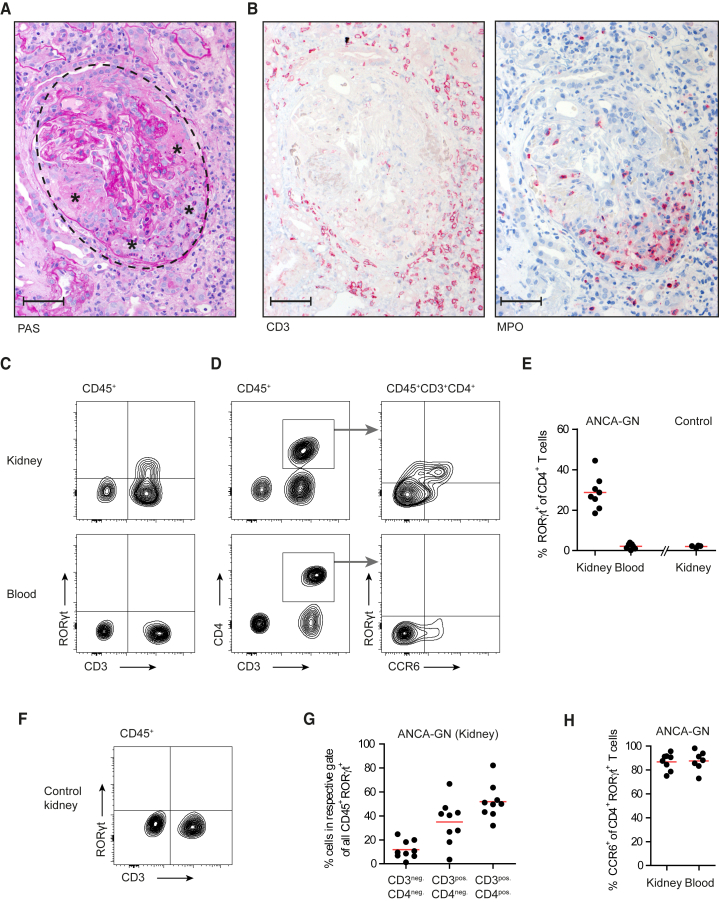
Identification and Characterization of Th17 Cells in the Kidneys of Patients with ANCA-Associated cGN(A) PAS staining of a renal biopsy from a patient with ANCA-GN (glomerulus: dashed line; crescent: asterisked).(B) Consecutive tissue sections were stained for CD3 (T cells) and MPO (neutrophils).(C) Leukocytes from renal biopsies and peripheral blood samples from ANCA-GN patients were analyzed by flow cytometry.(D) CD3+CD4+ cells were analyzed for expression of RORγt and CCR6.(E) Quantification of RORγt+CCR6+ cells of all CD4+ T cells in kidney and blood (ANCA-GN) and control biopsies (unaffected renal tissue of explanted kidneys after tumor nephrectomy).(F) Flow cytometry of control biopsies (CD45+ cells).(G) Quantification of CD45+RORγt+ cells from the kidneys of patients with ANCA-GN as indicated.(H) CCR6 expression of RORγt+CD4+ T cells from the kidney and peripheral blood (ANCA-GN). Symbols represent individual data points with the mean as a horizontal line. Scale bar, 30 μm. See also Figure S1.